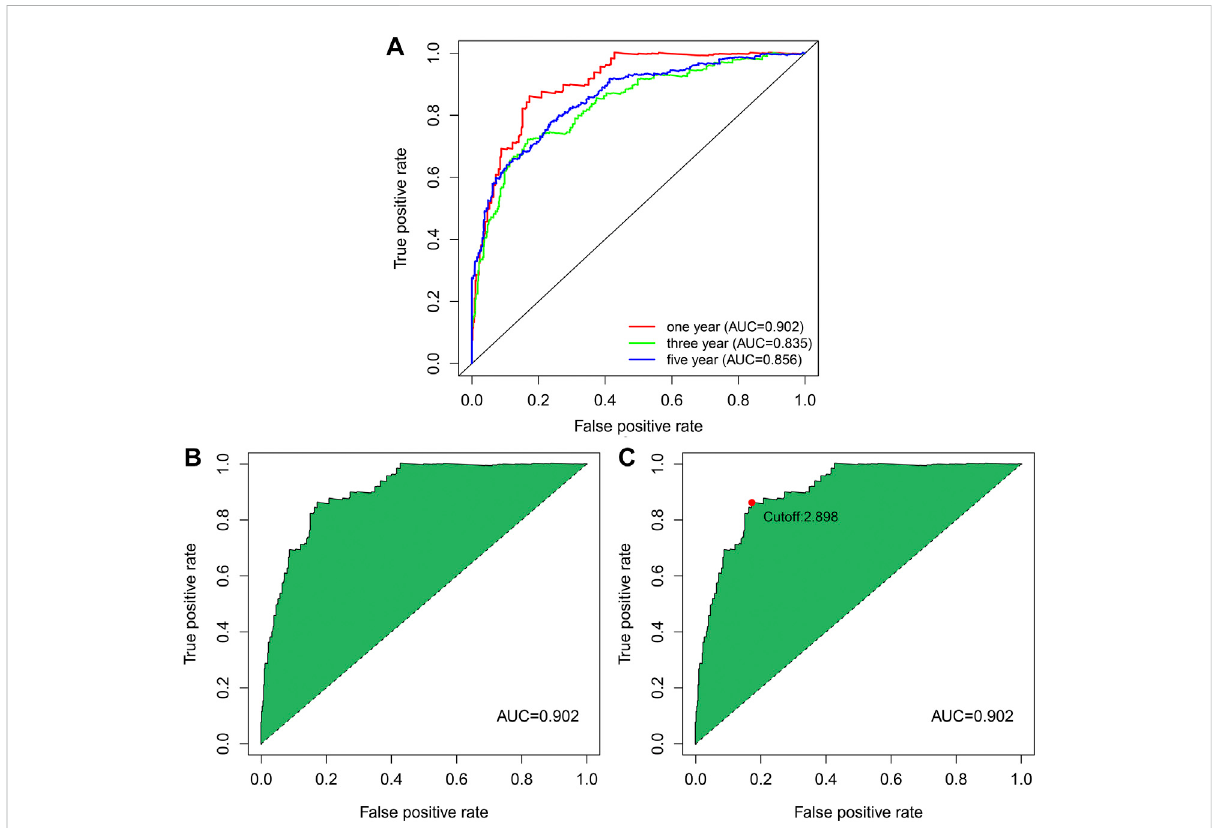
FIGURE 3 ROCcurveofnrlncRNApairssignature. (A) 1-year,3-years,and5-yearsROCpro fi les. (B) ROCcurvewithbestAUCvalueover1year. (C) Cut-off point calculated by